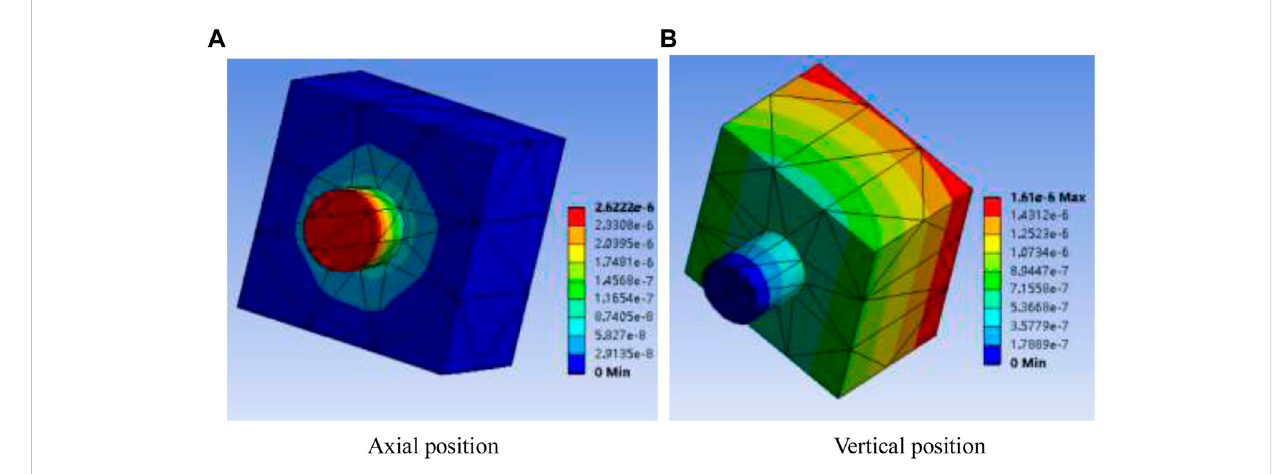
FIGURE 2 Simulation of stress under different states.